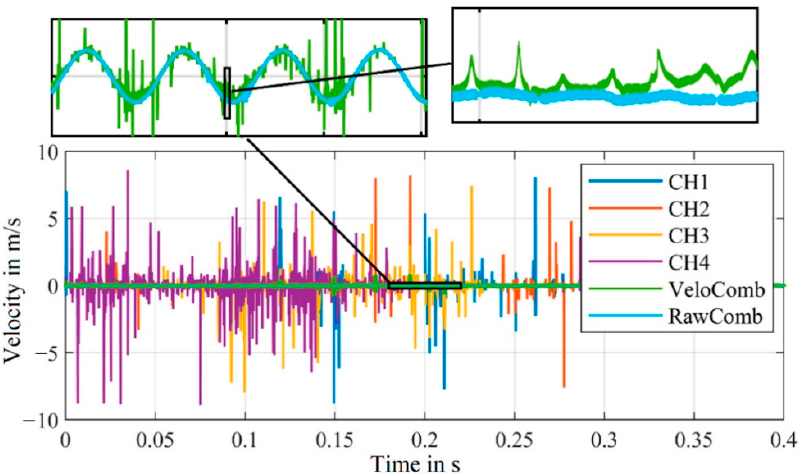
Figure 11. Comparison of the demodulated velocity signals of the channels CH1–CH4 and the combined signals (from [21] “VeloComb” and from our algorithm “RawComb”); zoomed sections only for combined signals to illustrate less noise; (RBW = 2.5 Hz).